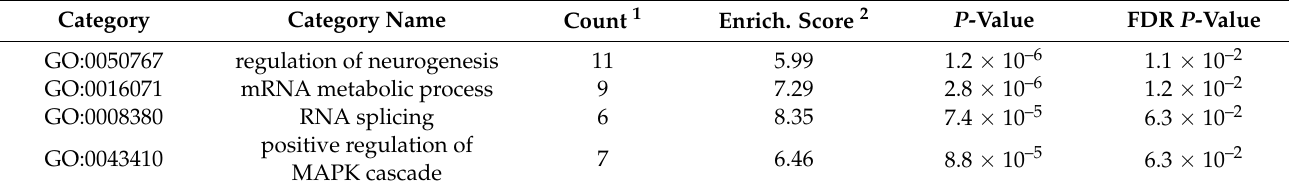
Table 5. Genes presenting simultaneously two splicing modes of action (absolute-DE, or relative-AS) in one region (nucleus accumbens-NAc, or trigeminal ganglia-TG) or one mode of action in two regions. Group 1 Genes Detected in Two Differential Splicing-Region Categories 2 NAc Prpf40b,Grin1,Ablim2,Rbm3,Hebp2,Ciz1,Dhx30,Fam219a,Hnrnpa1 TG Asap1,Scn8a,Eef1d,Map2,Rbm39,Cnot1,Fabp7,Ciart,Fam222b,Peg3 DE Slc38a4,Pak3,Prg4,Csde1,Celf3,Cacna1g,Ndst3,AC166328.1,Mapk8ip3 4933431E20Rik,Rasl10a,Fabp7,Ssbp2,Hnrnpk,Plce1,Tenm4,Cdon,Zfp948, AS Rbm3,Clasp2,Spag9,Ptpn23,Mprip,Cadps,Mink1,Prune2,Asap1,Fam184a, Podxl2,Sema4c,Smpdl3a 1 Group = genes presenting simultaneous absolute and relative splicing action modes in NAc or TG, and genes presenting either DE or AS action simultaneously in both regions. 2 Gene names: 4933431E20Rik = RIKEN cDNA 4933431E20 gene; Ablim2 = actin-binding LIM protein 2; Asap1 = ArfGAP with SH3 domain, ankyrin repeat and PH domain1; Cacna1g = calcium channel, voltage-dependent, T type, alpha 1G subunit; Cadps = Ca2+-dependent secretion activator; Cdon = cell adhesion molecule-related/down-regulated by oncogenes; Celf3 = CUGBP, Elav- like family member 3; Ciart = circadian associated repressor of transcription; Ciz1 = CDKN1A interacting zinc finger protein 1; Clasp2 = CLIP associating protein 2; Cnot1 = CCR4-NOT transcription complex, subunit 1; Csde1 = cold shock domain containing E1, RNA binding; Dhx30 = DEAH (Asp-Glu-Ala-His) box polypeptide 30; Eef1d = eukaryotic translation elongation factor 1 delta; Fabp7 = fatty acid binding protein 7, brain; Fam184a = family with sequence similarity 184, member A(Fam184a); Fam219a = family with sequence similarity 219, member A; Fam222b = family with sequence similarity 222, member B; Grin1 = glutamate receptor, ionotropic, NMDA1 (zeta 1); Hebp2 = heme binding protein 2; Hnrnpa1 = heterogeneous nuclear ribonucleoprotein A1(; Hnrnpk = heterogeneous nuclear ribonucleoprotein K; Map2 = microtubule-associated protein 2; Mapk8ip3 = mitogen- activated protein kinase 8 interacting protein 3; Mink1 = misshapen-like kinase 1; Mprip = myosin phosphatase Rho interacting protein; Ndst3 = N-deacetylase/N-sulfotransferase 3; Pak3 = p21 protein (Cdc42/Rac)-activated kinase 3; Peg3 = paternally expressed 3; Plce1 = phospholipase C, epsilon 1; Podxl2 = podocalyxin-like 2; Prg4 = proteoglycan 4; Prpf40b = pre-mRNA processing factor 40B(Prpf40b); Prune2 = prune homolog 2; Ptpn23 = protein tyrosine phosphatase, non-receptor type 23; Rasl10a = RAS-like, family 10, member A Rbm3 = RNA binding motif protein 3; Rbm39 = RNA binding motif protein 39; Scn8a = sodium channel, voltage-gated, type VIII, alpha; Sema4c = sema domain, immunoglobulin domain (Ig), transmembrane domain (TM) and short